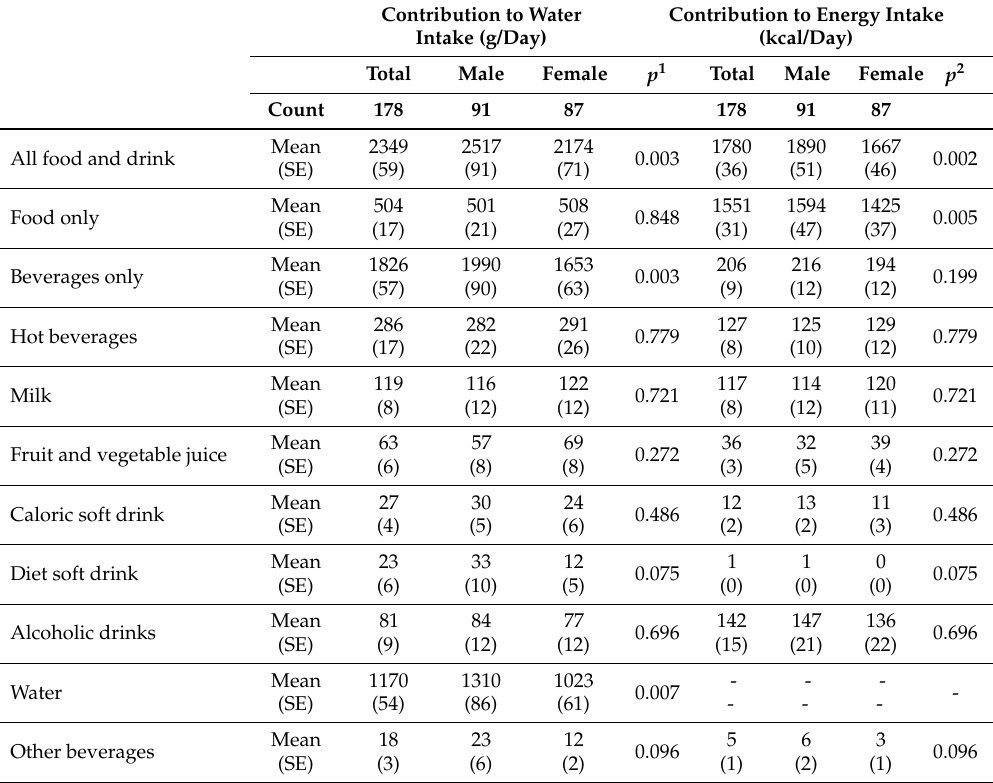
Table 6. Contribution of foods and beverages to water and energy intake using seven-day diaries ( n = 178).